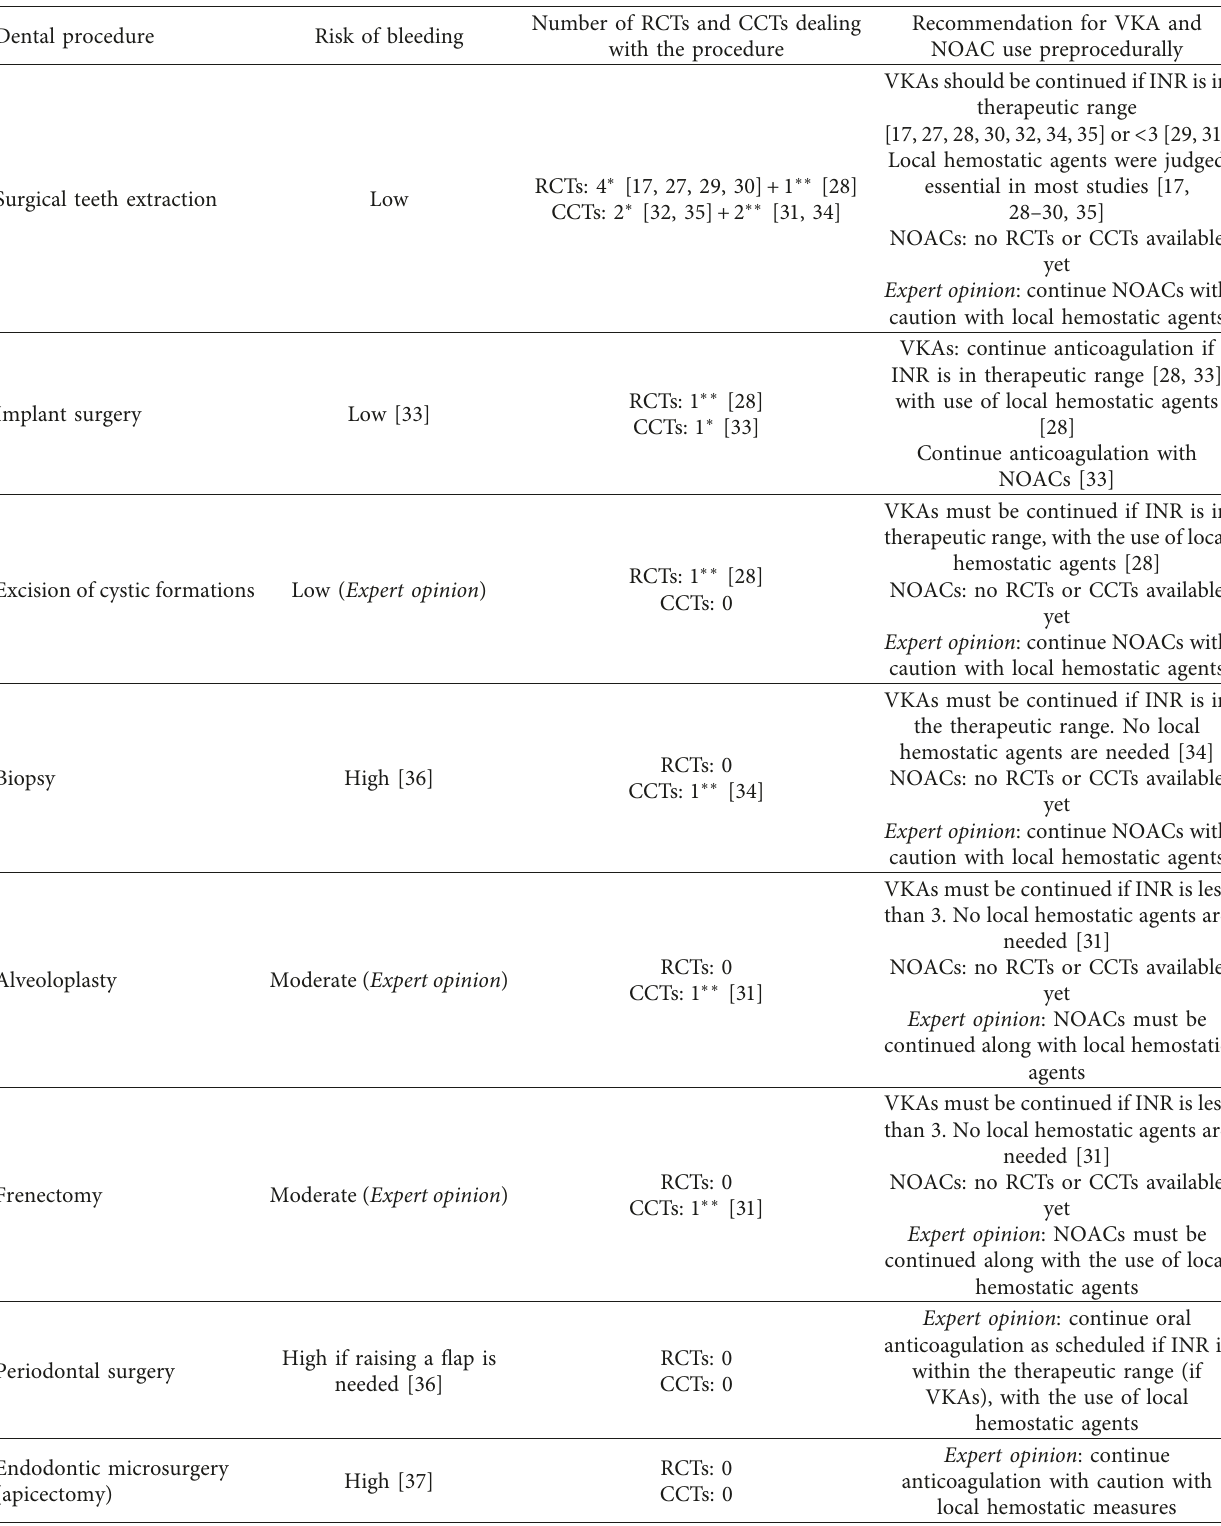
Table 3: Recommendations for specific dental procedures based on corresponding RCTs, CCTs, and/or expert